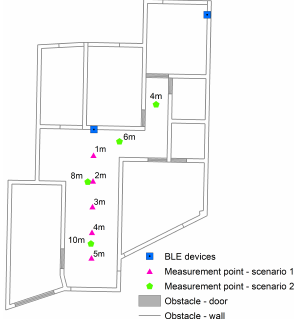
Figure 4. Measuring points for defining parameters A and n